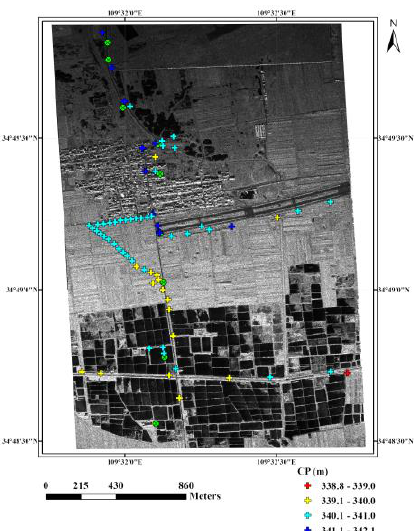
Figure 4. The distribution of 70 CPs superimposed on amplitude image